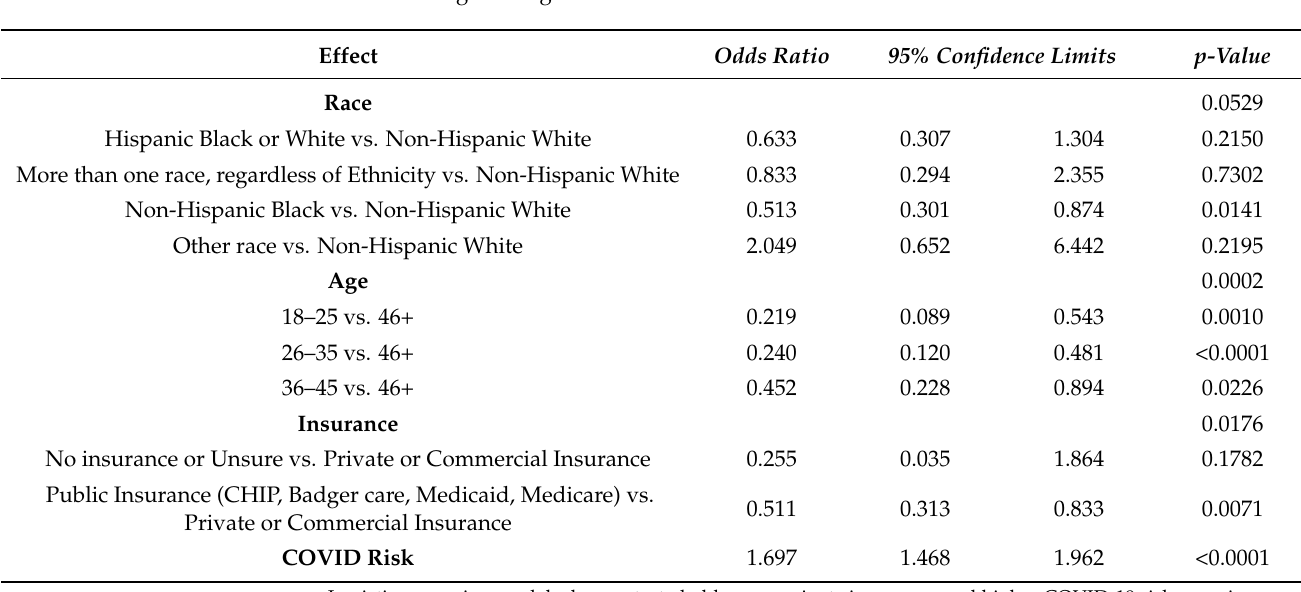
Table A2. Logistic Regression Model for Plans to Vaccinate Child for